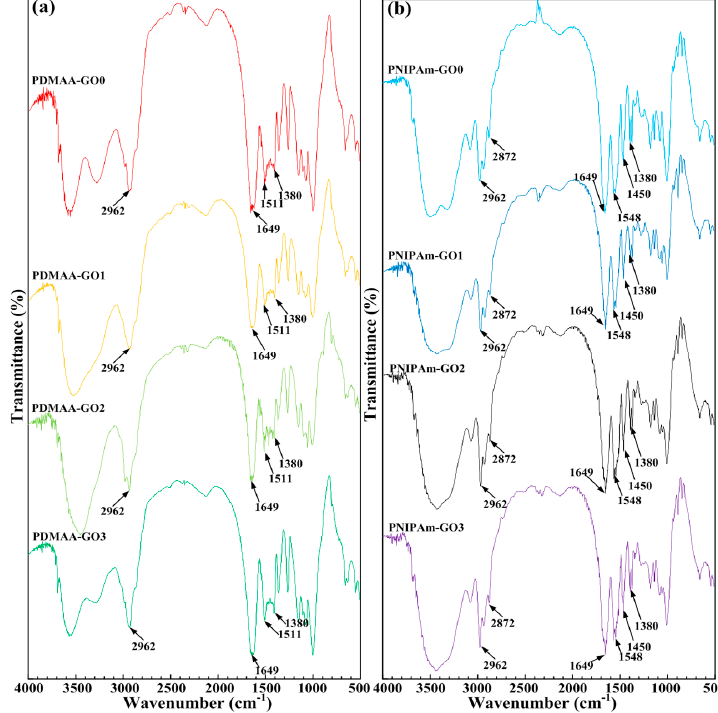
Figure 3. Typical FT-IR spectra characteristics of ( a ) PDMAA hydrogels and ( b ) PNIPAm hydrogels with various GO contents.